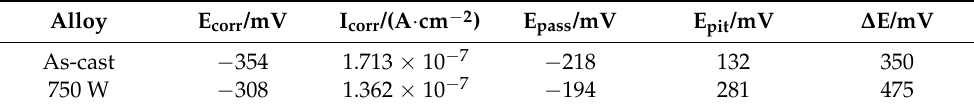
Table 2. Electrochemical parameters of the AlCoCrFeNi 2.1 HEA in a 3.5 wt.% NaCl solution before and after